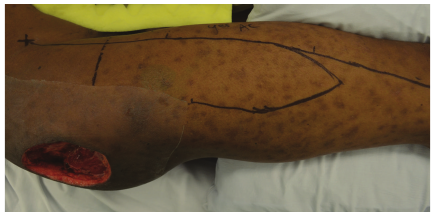
Figure 3: Design of a tensor fascia lata